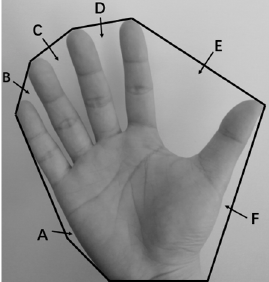
Figure 12. the convex hull and convex defects.